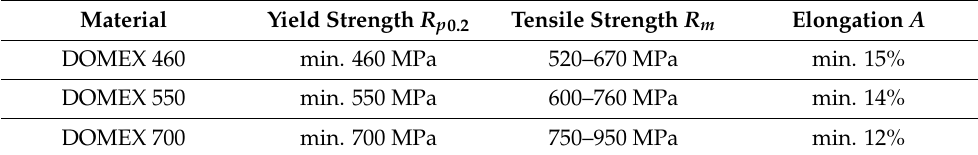
Table 3. Basic mechanical properties of DOMEX 460 steels (SSAB datasheets)